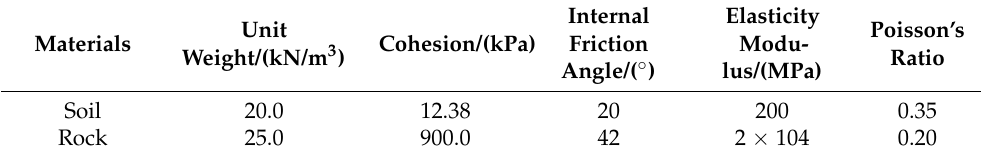
Figure 15. Geometric parameters for Example 3: soil–rock mixture slope. Table 1. Material parameters.